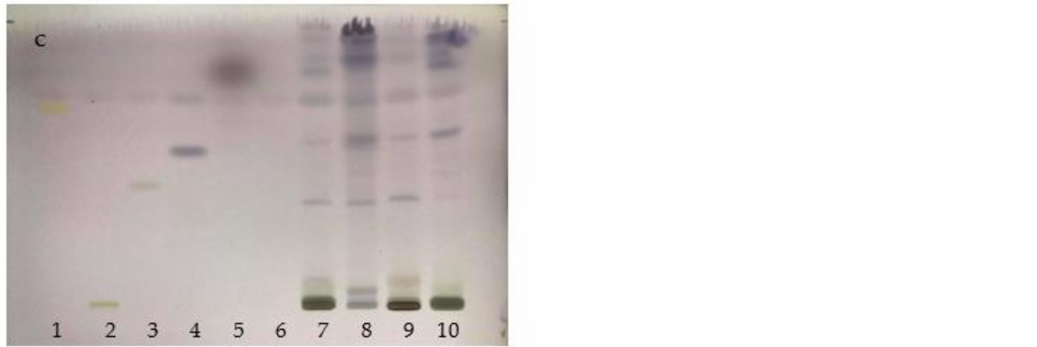
Figure 6. TLC chromatograms of water extract of TS remedy; ( a ) UV at 254 nm; ( b ) UV at 366 nm; ( c ) anisaldehyde-sulfuric acid spraying reagent; (1) kaempferol; (2) rutin; (3) gallic acid; (4) caffeic acid; (5) linalool; (6) cineol; (7) TS remedy; (8) Coriandrum sativum L. extract; (9) Aegle marmelos (L.) Corr ê a extract; and (10) Morinda citrifolia L. extract.